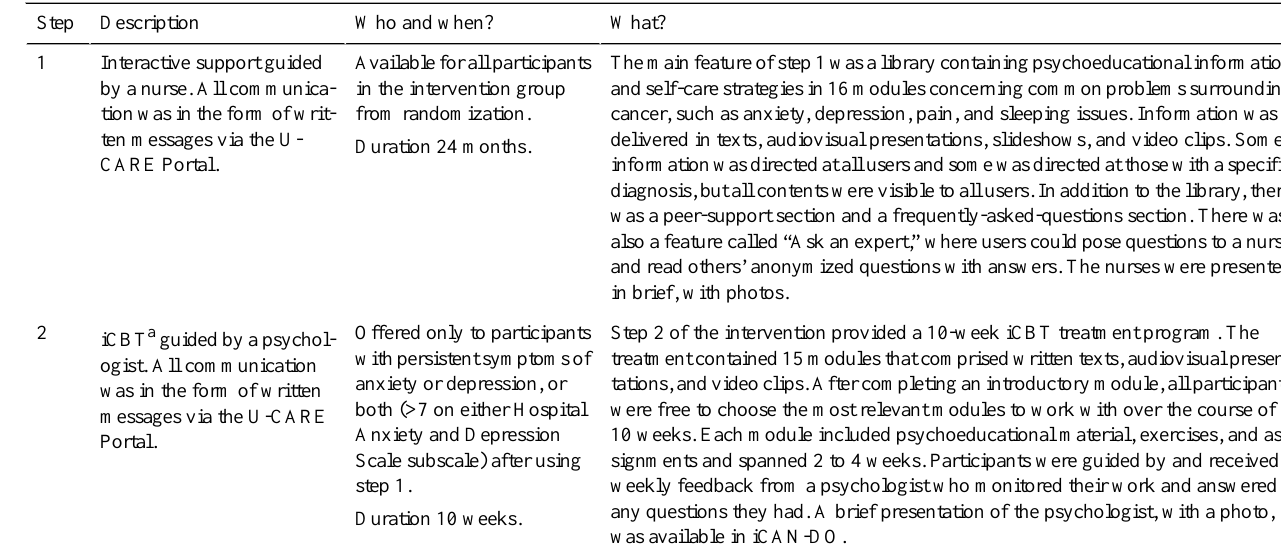
Table 1. Content and features of the internet-based stepped care in the iCAN-DO application, aimed at individuals with cancer and concurrent symptoms of anxiety and